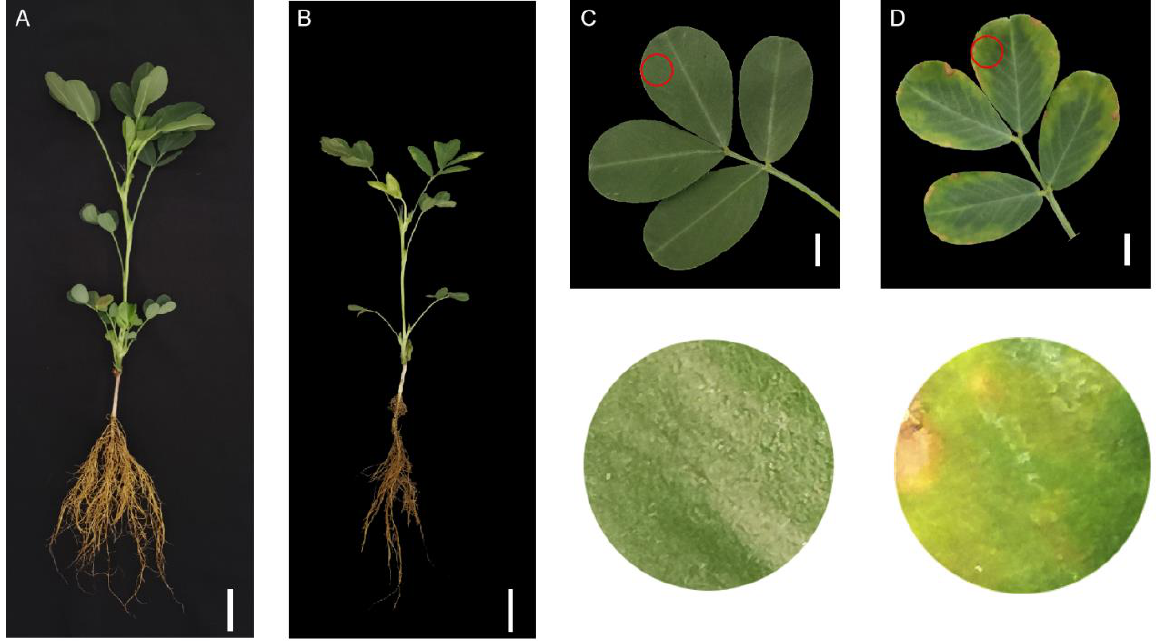
Figure 1. Varying Mn concentrations had different effects on peanut development. Peanut plant morphologies at different Mn concentrations: ( A ) 10 μM, ( B ) 300 μM (bars = 3 cm); leaf phenotypes at different Mn concentrations: ( C ) 10 μM, ( D ) 300 μM (bars = 2 cm). The diameter of the red circle was 2 cm. The figures below show the magnified outcome of the red circle.